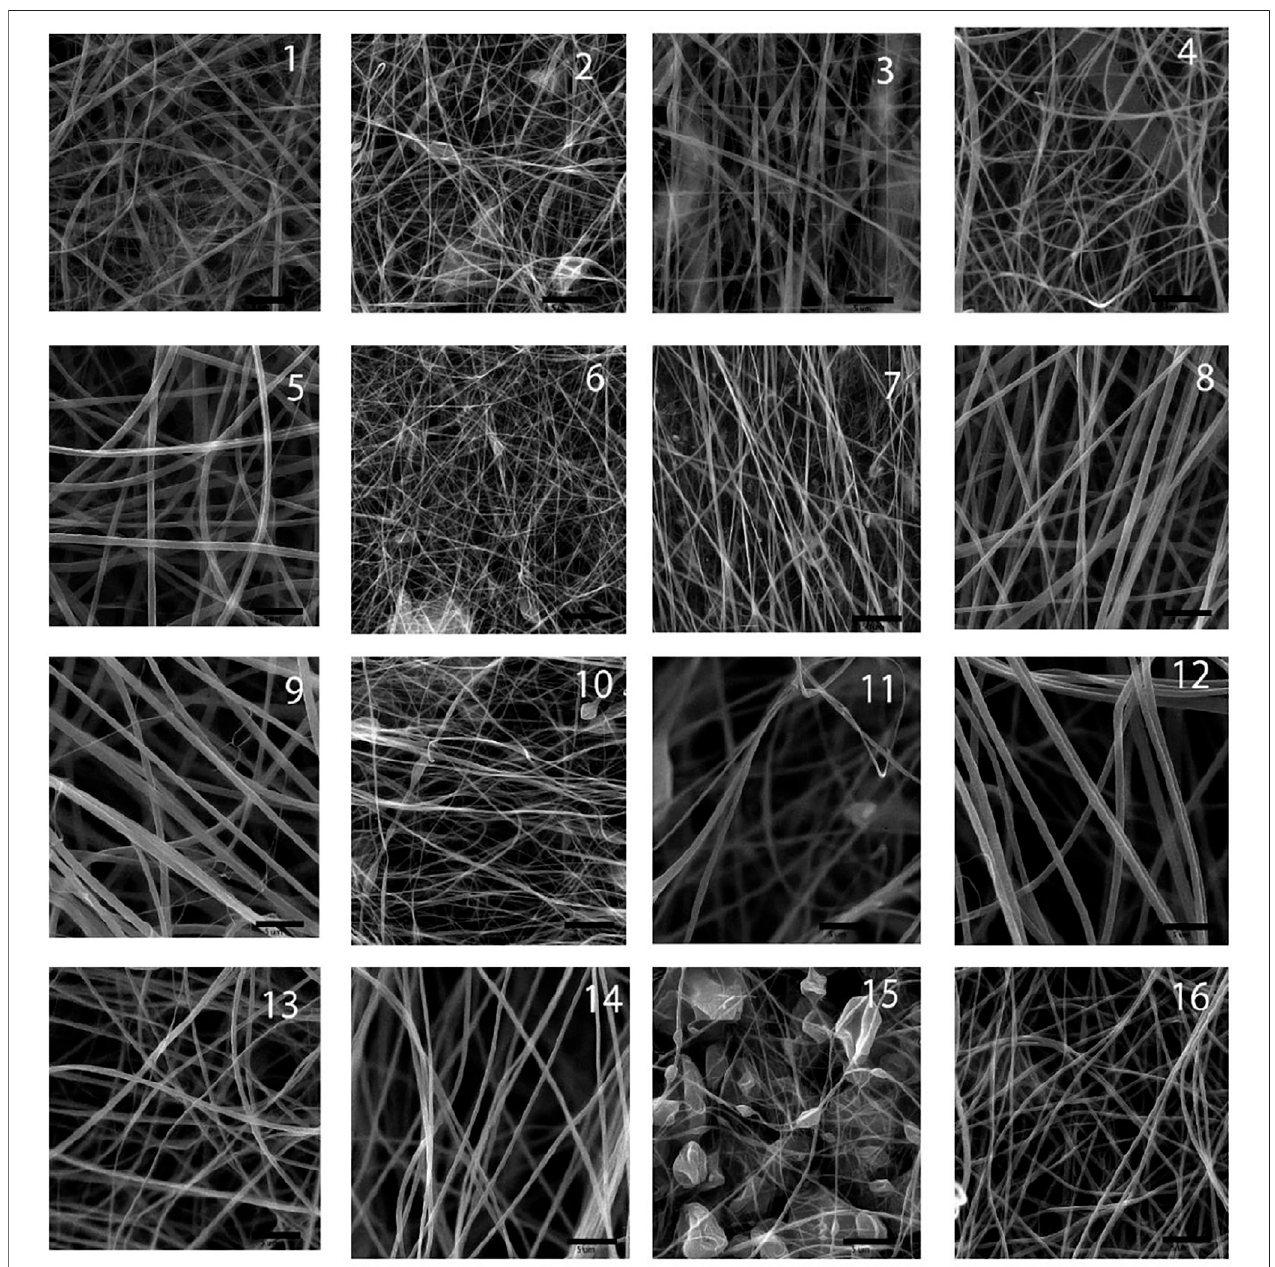
FIGURE 1 | SEM images of the fabricated